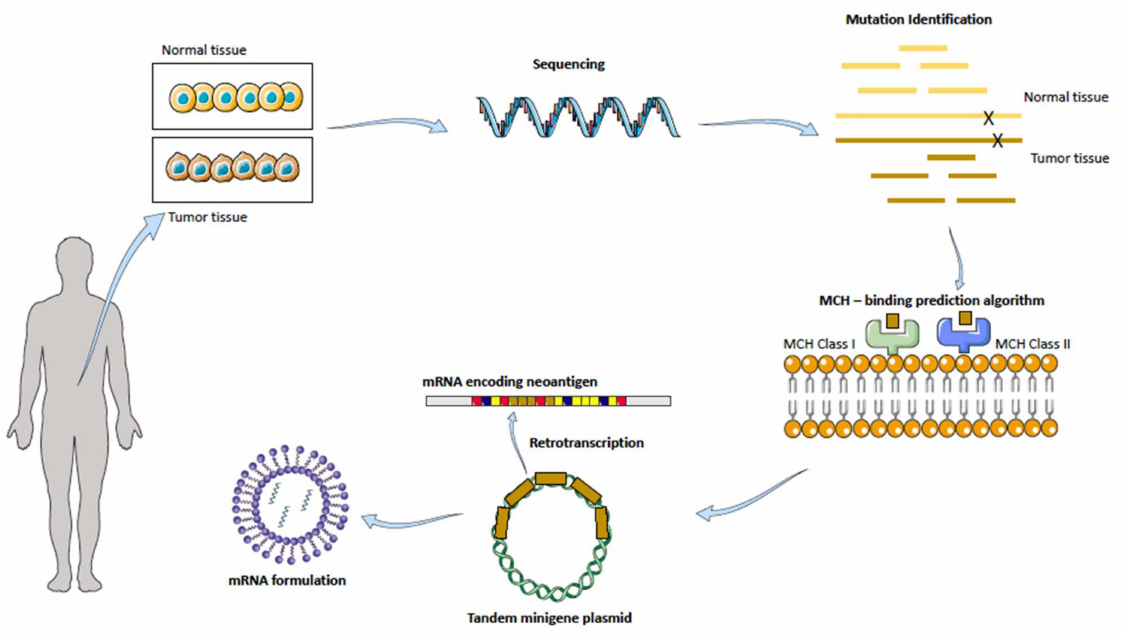
Figure 5. Personalized mRNA cancer vaccines. Healthy and tumor tissue are isolated from the patient sample, analyzed and compared in order to find mutations present in the tumor tissue. Bioinformatic tools are used to predict the MCH Class I and II binding. A tandem gene encoding for several neoantigens is then designed and retrotranscribed to mRNA. Finally, by making use of nanotechnology, the mRNA is formulated and delivered. Adapted with permission from [159], published by Nature Reviews Drug Discovery,